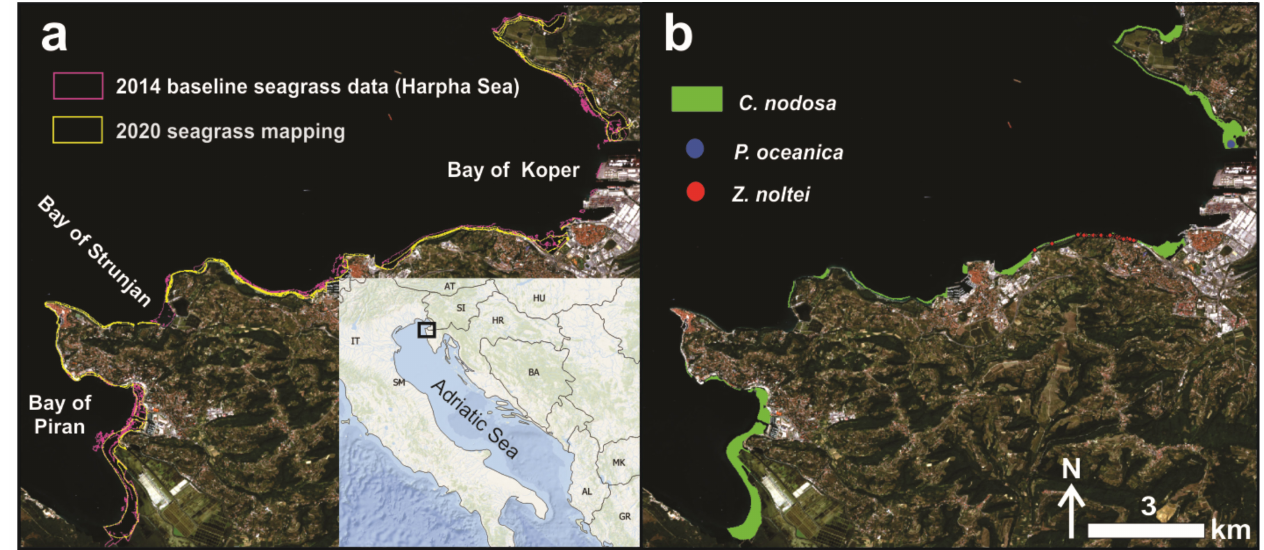
Figure 1. The 2014 baseline seagrass status and the 2020 mapping in the study area ( a ). Spatial distribution of C. nodosa , P. oceanica and Z. noltei ( b